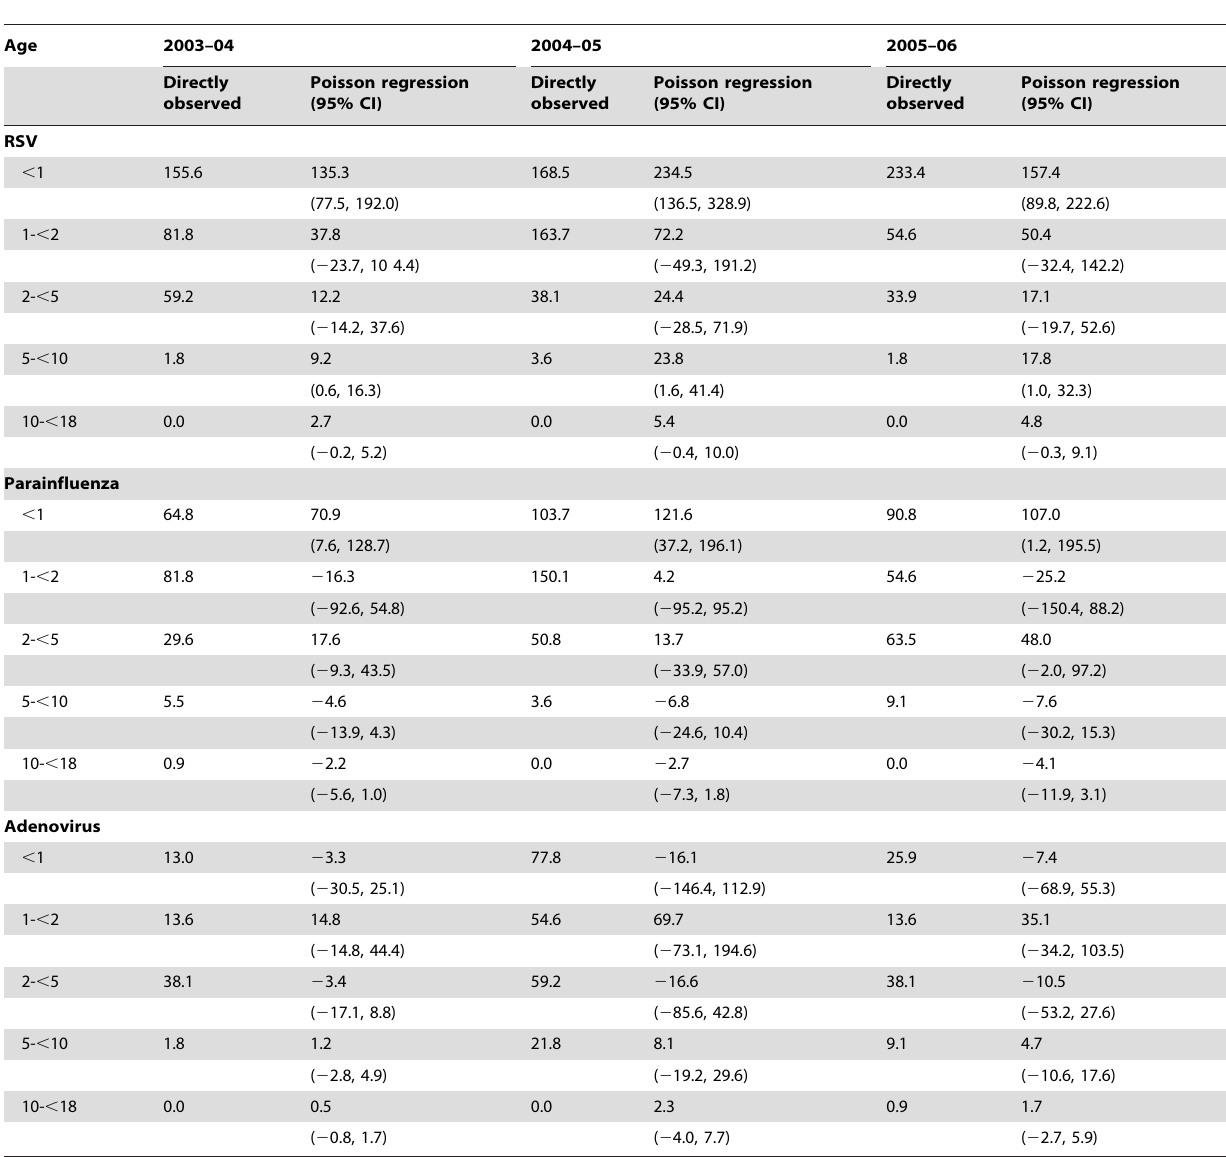
Table 2. The ARD hospitalization rate (per 10,000) associated with respiratory syncytial virus (RSV), parainfluenza and adenovirus in patients , 18 years on Hong Kong